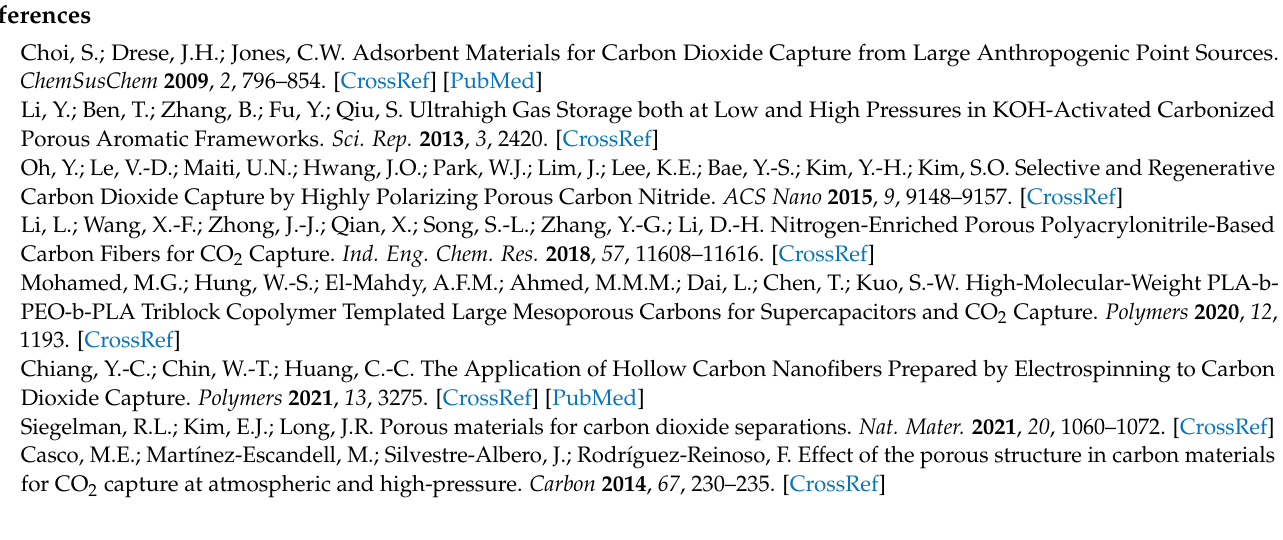
temperature, Figure S2: XPS N1s spectrum of co-UNs, Figure S3: FT-IR spectra of co-UNs and co- RUNs, Figure S4: SEM images of co-RUNs, Figure S5: N 2 and CO 2 adsorption isotherms of co-RUNs collected at 298 K, Figure S6: CO 2 IAST selectivity of co-RUNs, Figure S7: CO 2 adsorption-desorption isotherm curve of co-RUNs, Figure S8: CO 2 heat of adsorption of co-RUNs, Table S1: Monomer composition of co-UNs, Table S2: Nitrogen functional group ratio of co-UNs, Table S3: Elemental ratio of co-UNs and co-RUNs, Table S4: Estimated monomer weight percent of co-UNs, Table S5: BET surface area and t-plot micropore surface area of